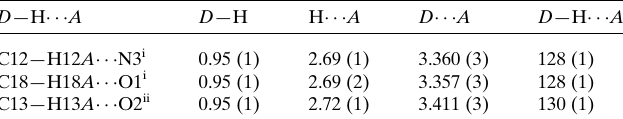
Table 2 Hydrogen-bond geometry (A˚ , (cid:4)